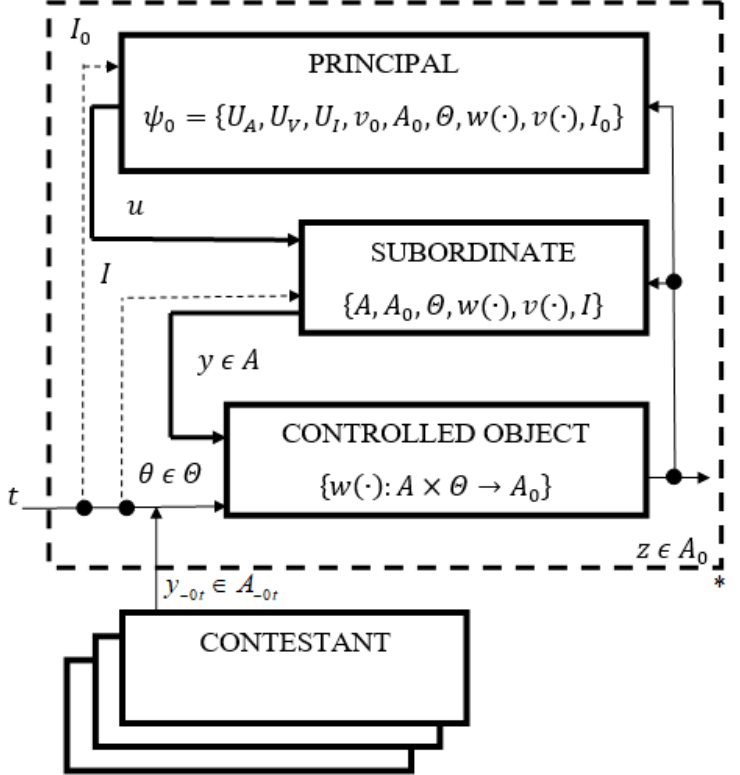
Figure 1. The structure of the control system of the construction firm and external contestant. * The zone marked with a dotted line corresponds to the general statement of the organizational behavior control problem (Novikov 2013).